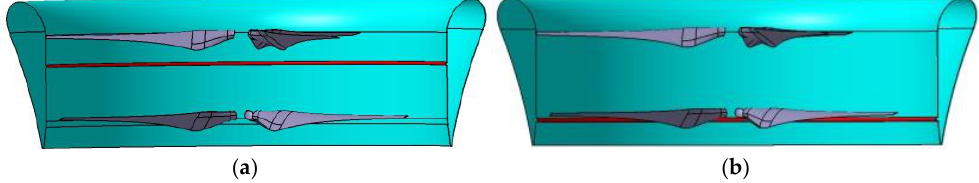
Figure 14. Results after adding VRR: ( a ) VRR in straight section; ( b ) VRR in diffusion section. Table 2. Lift and torque distribution of different components.